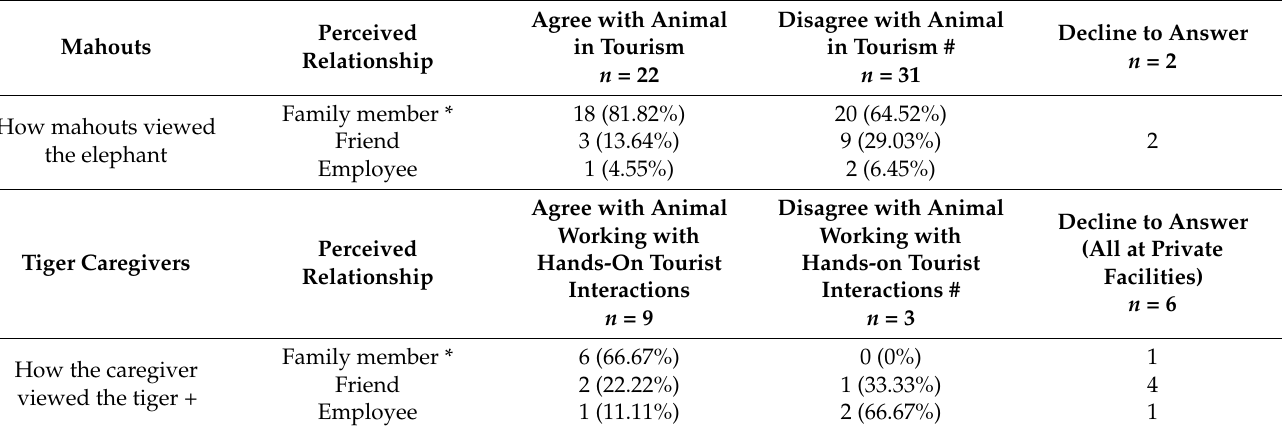
Table 7. Caregivers’ perspectives on animal